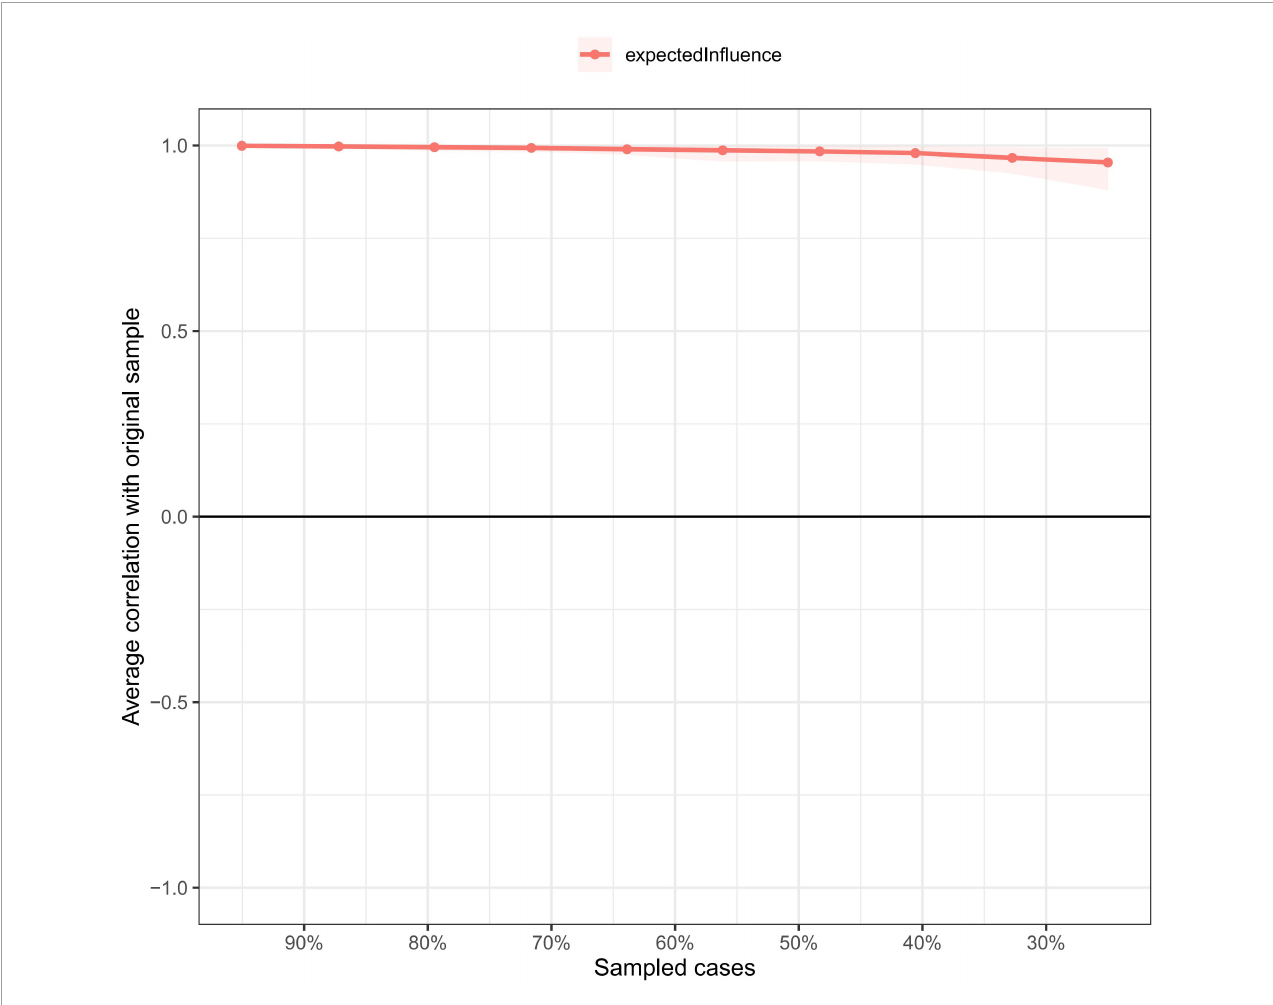
FIGURE3 Network stability of insomnia symptoms among Macau residents during the COVID-19